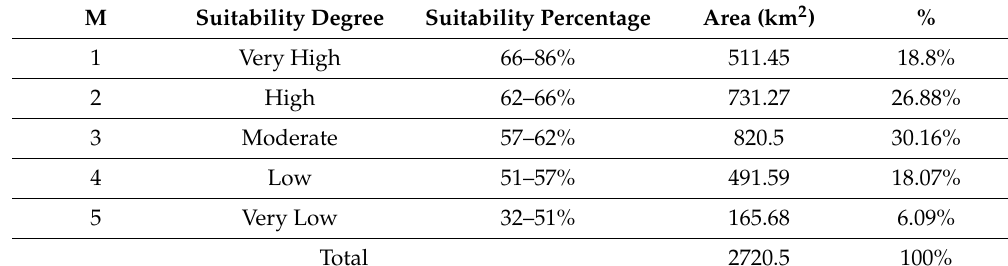
Table 9. Relative importance to spatial suitability for constructing new urban areas in the Ar Riyadh–Al kharj urban–rural continuum.